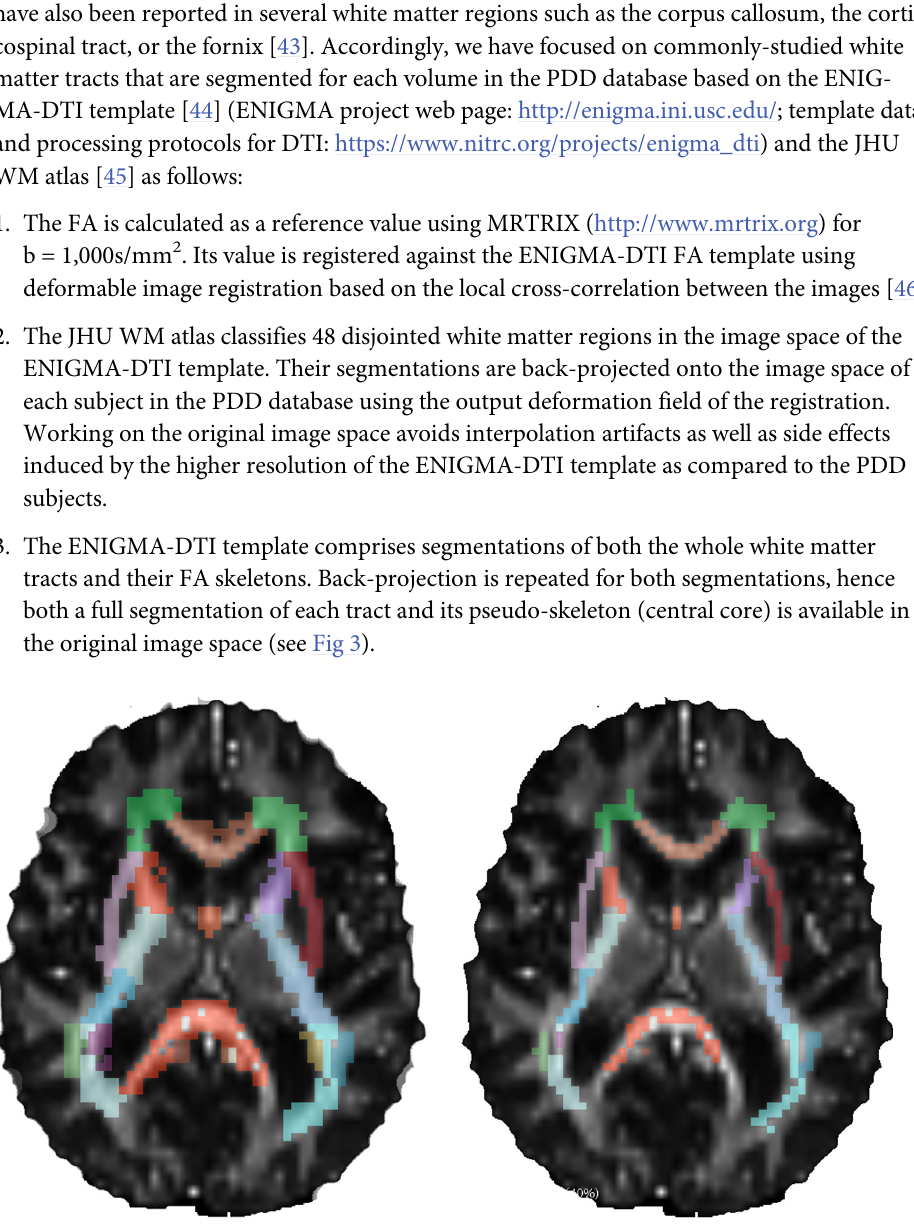
Fig 3. Registration-based segmentation of WM tracts of a control subject in the PDD database. (Left) Whole tracts. (Right) Pseudo-skeletons.